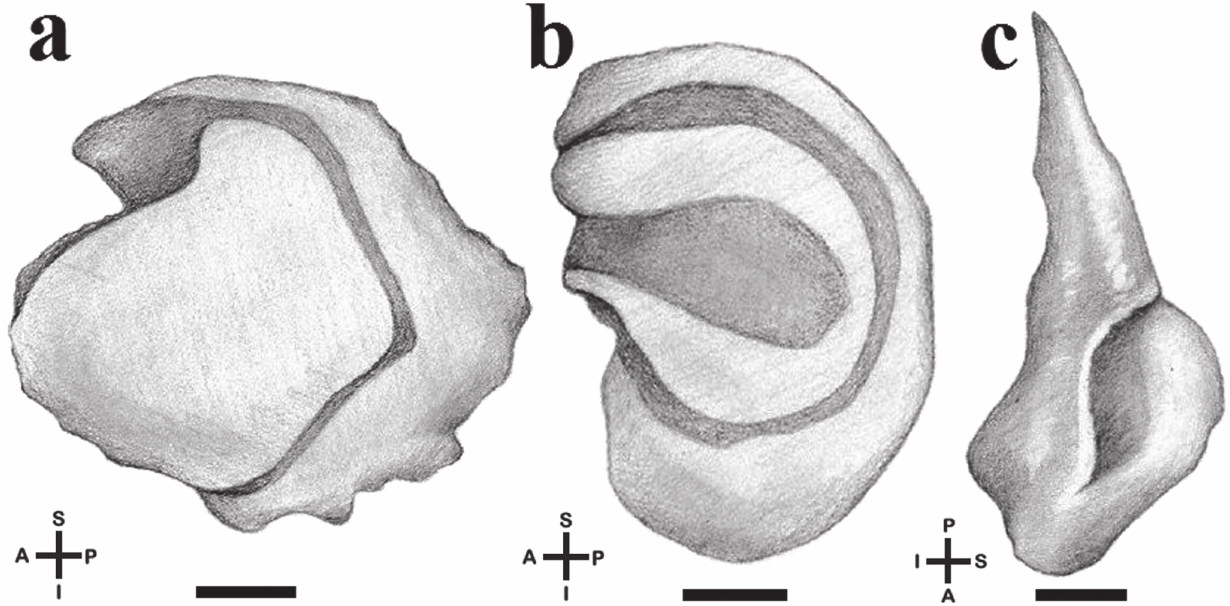
Fig. 11. Right serie of otoliths of Pterygoplichthys anisitsi (a) Lapillus, Scale bar = 500 µm; (b) Asteriscus, Scale bar = 500 µm; (c) Sagitta, Scale bar = 500